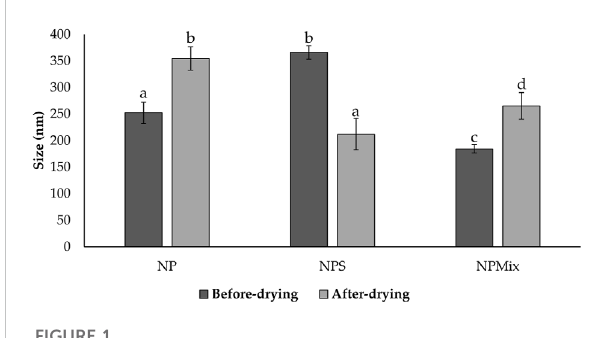
FIGURE 1 Size comparison of the nanoparticles of different batches of NP, NPS and NPMix before and after drying. Data are reported as mean value ± standard deviation, n = 9. Letters (a, b, c, and d) are used to compare the means of different groups. If the letters are different, there is a statistically signi fi cant difference between the means ( p < 0.001); if the letters are the same, there is no statistically signi fi cant difference between the means ( p >